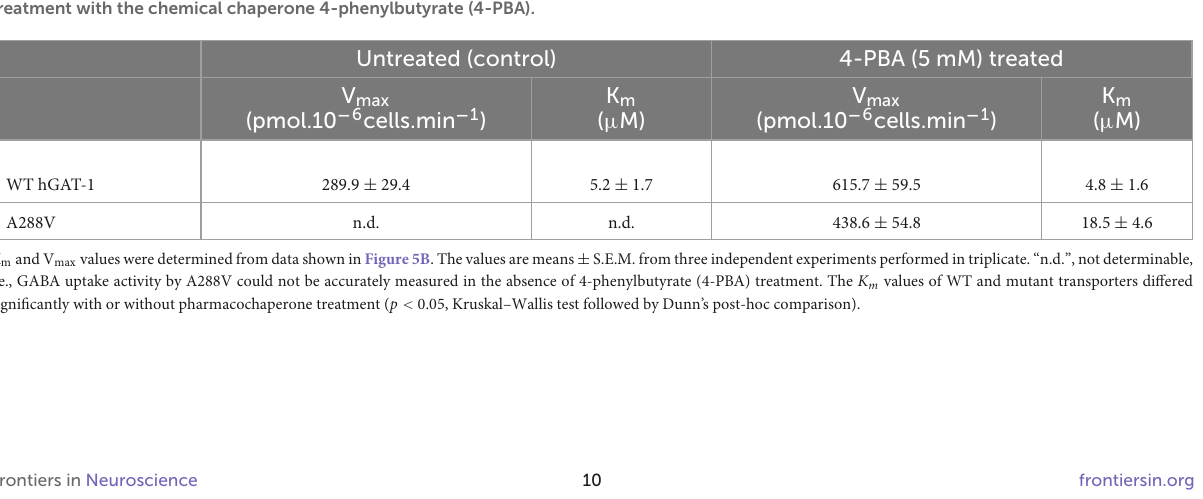
TABLE 1 Kinetic parameters of GABA uptake by wild type human GABA transporter 1 (hGAT-1) and its epilepsy variant A288V, before and after treatment with the chemical chaperone 4-phenylbutyrate (4-PBA).